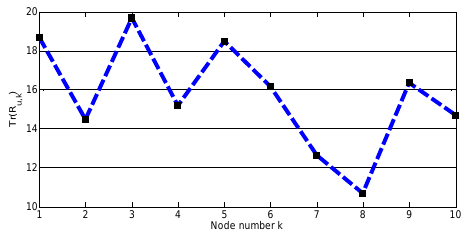
Figure 3. Trace of regressor covariances Tr(R u,k ).